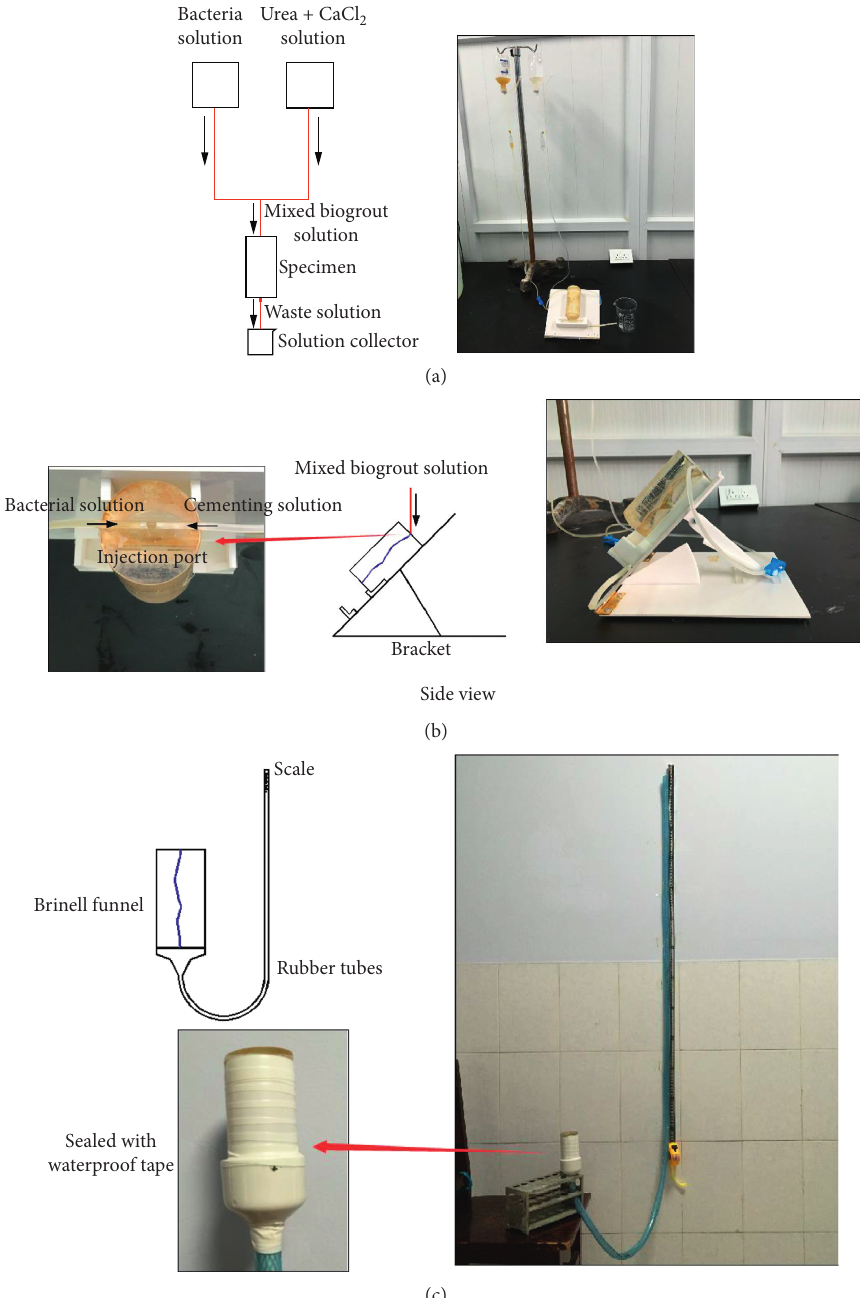
Figure 5: Experimental setup. (a) Schematic of biogrout solution flow arrangement. (b) Side view of experimental bracket. (c) The measuring equipment of permeability